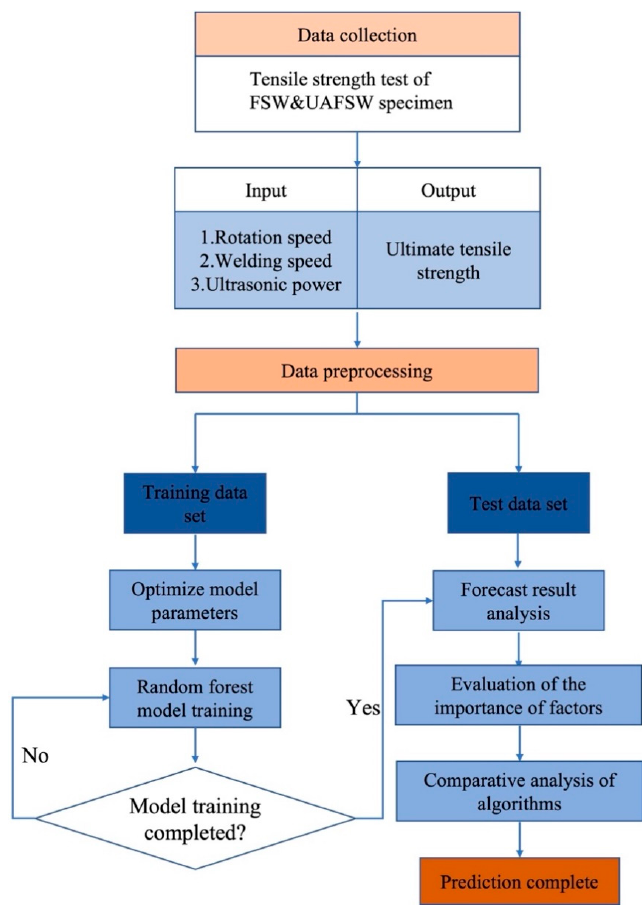
Figure 9. Flow chart of the random forest prediction model for UAFSW. 1. Created a mechanical performance data collection for UAFSW.